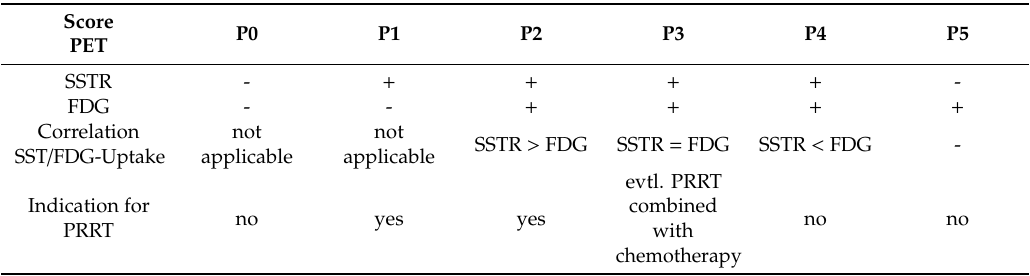
Table 2. The NETPET scores with a relevance of the peptide receptor radionuclide therapy (PRRT)